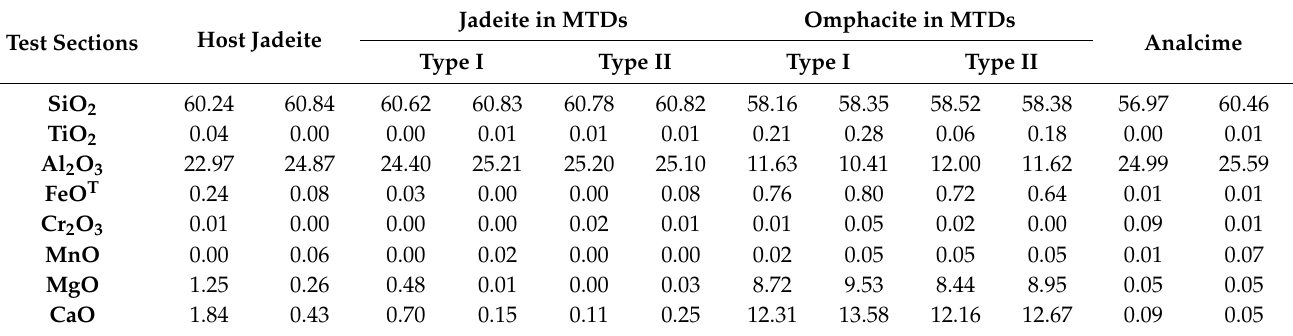
Table 1. The chemical compositions of jadeite, omphacite, and analcime in samples .